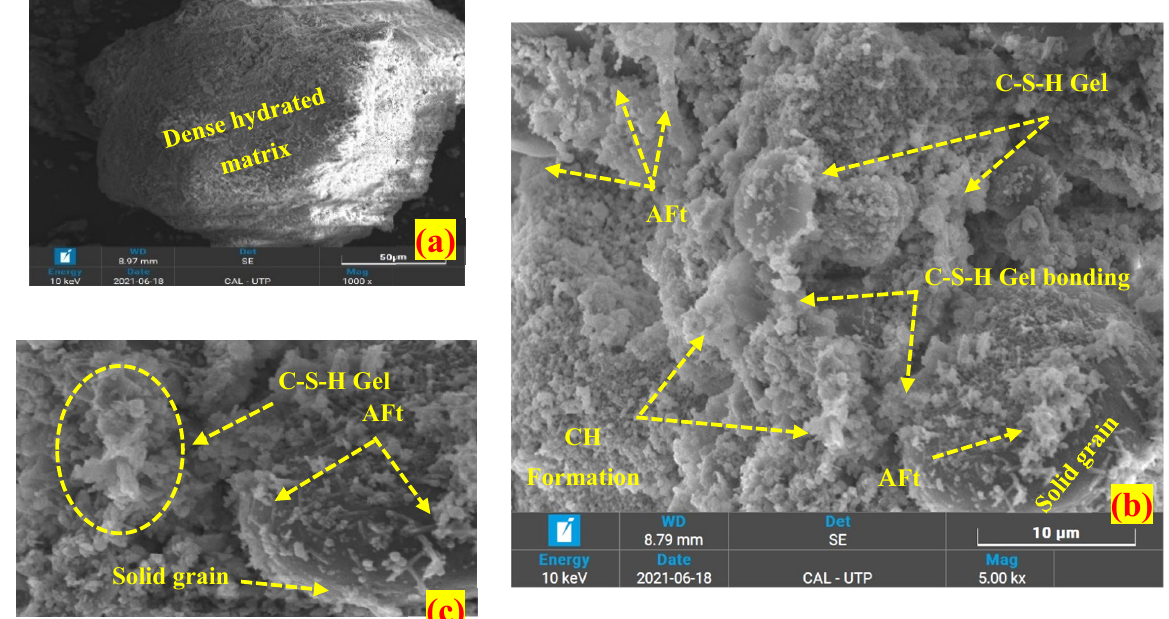
Figure 5. SEM images of 28 days cured OPC-SF stabilized peat ( a ) 1000 × , ( b ) 5000 × , ( c ) 10,000 × . Overall, the application of OPC, SF, and OPC-SF reduces the pores and improves the surficial characteristics by filling the void spaces and binding the peat components into a dense flocculated mass. Moreover, the development of calcium silicate hydrate (C-S-H), calcium aluminate hydrate (C-A-H), aluminum calcium oxide (C-A-O), and ettringites (AFt) are the indication of a strong interfacial bonding network which helps in the interlocking and friction coefficient among the soil particles [18,31]. These are the reasons treated